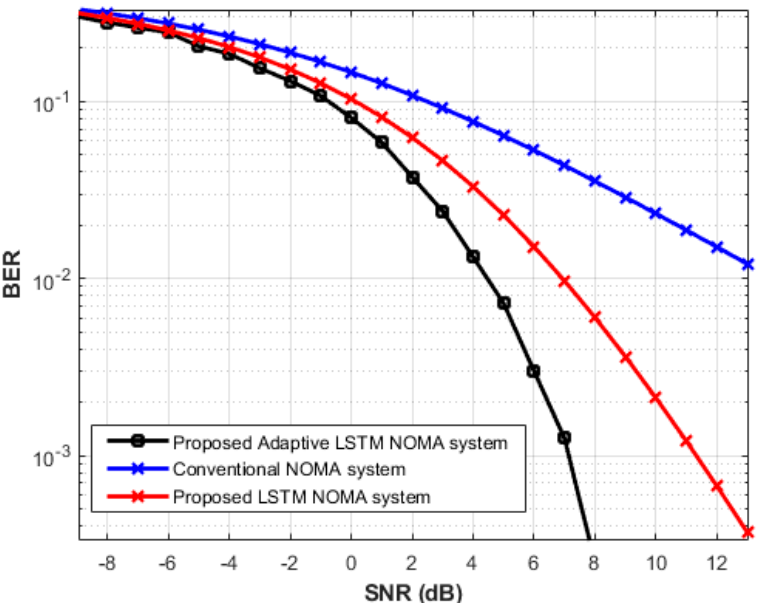
Figure 9. Bit error rate (BER) against the signal-to-noise ratio (SNR) for the proposed system versus the conventional NOMA and LSTM NOMA.